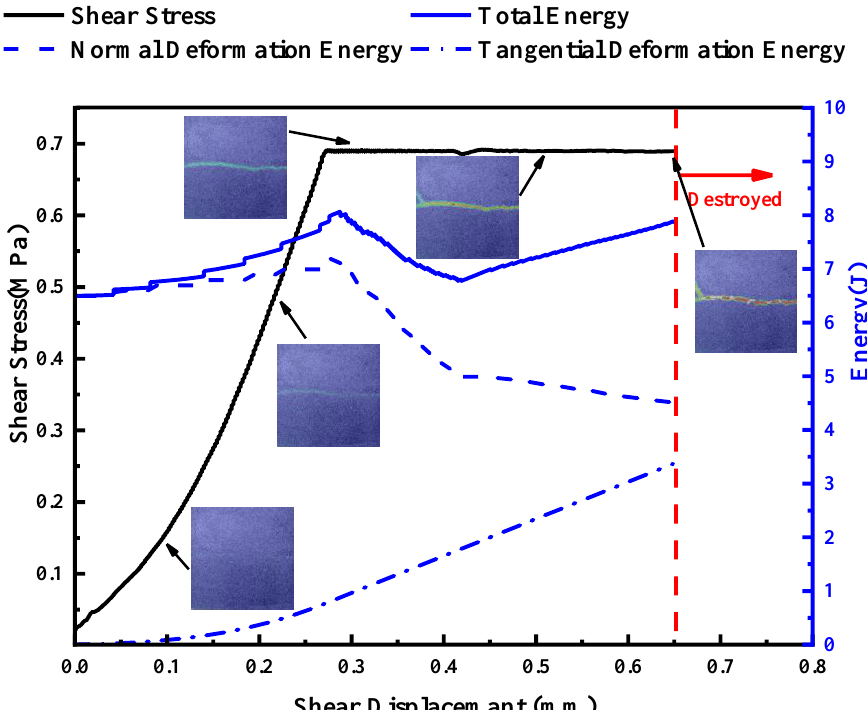
Figure 18. Curves of energy, shear stress and shear displacement.